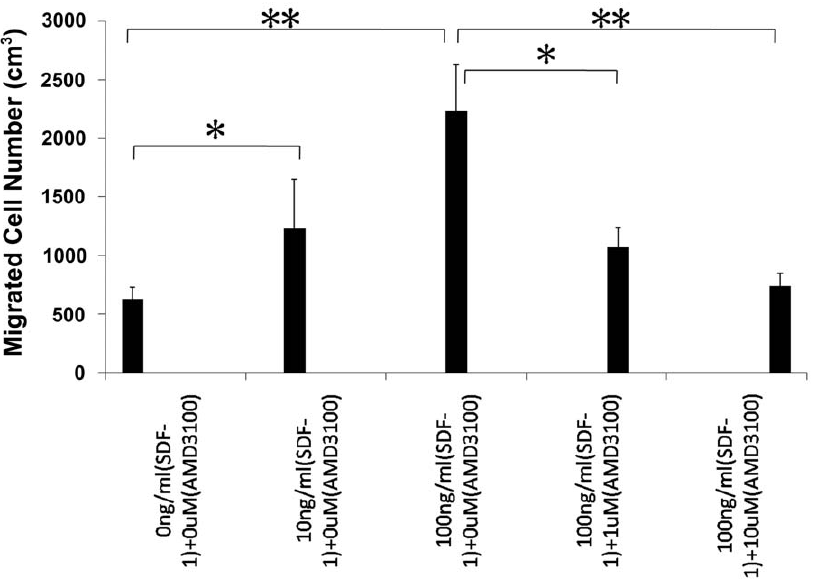
Figure 6. In vitro chemotaxis assay. 10 ng/ml rMuSDF-1 induced the migration of mouse BMSCs by 96%, and 100 ng/ml rMuSDF-1 by 254%. The effect was reduced after treated with AMD3100. Values are the mean and SD results from 4 independent experiments (*P , 0.05; **P , 0.001).